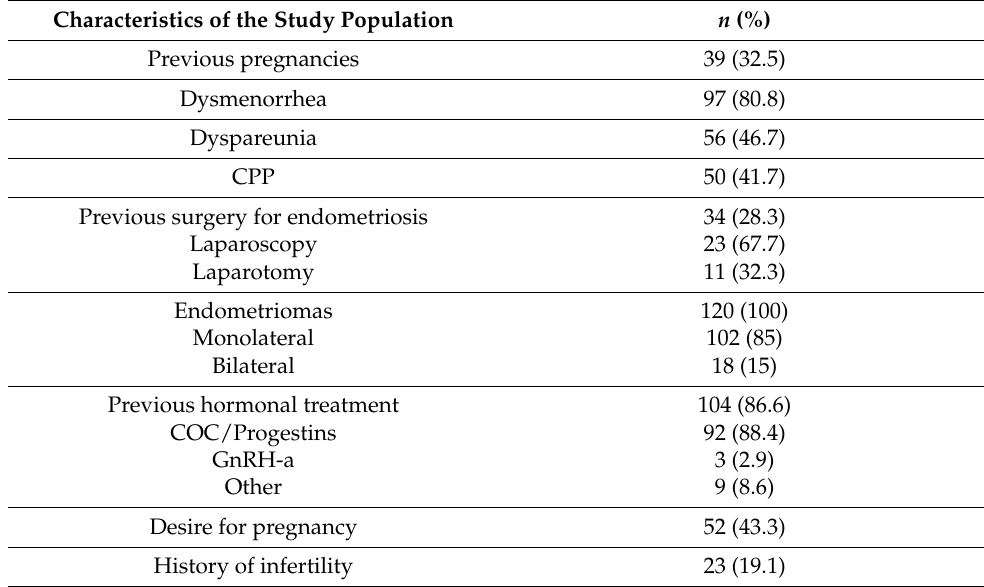
Table 1. General characteristics of the study population. Characteristics of the Study